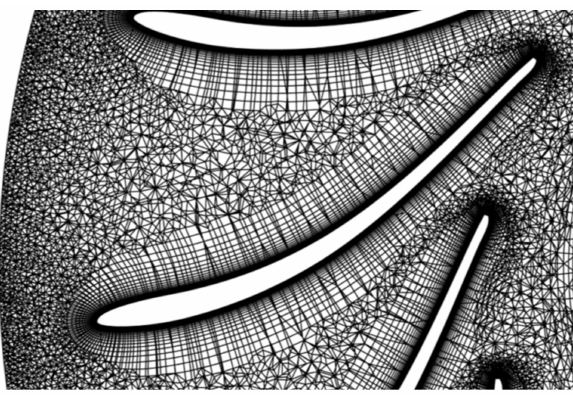
Figure 6. Cut view in volume runner